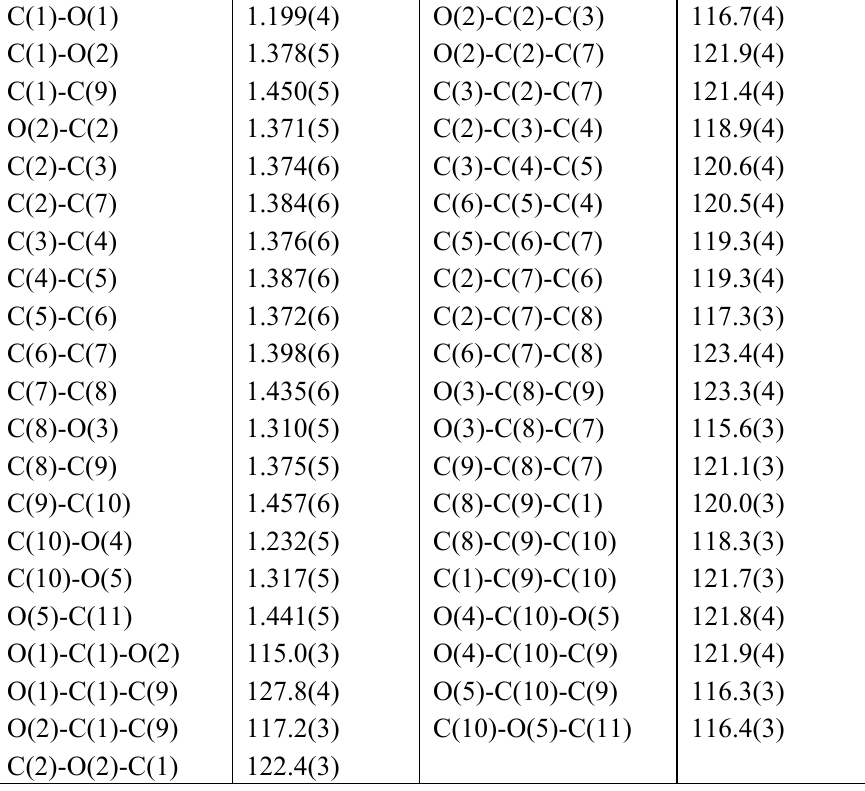
Table 2. Bond lengths [Å] and angles [°] for 3-methoxy-4-hydroxy coumarin.